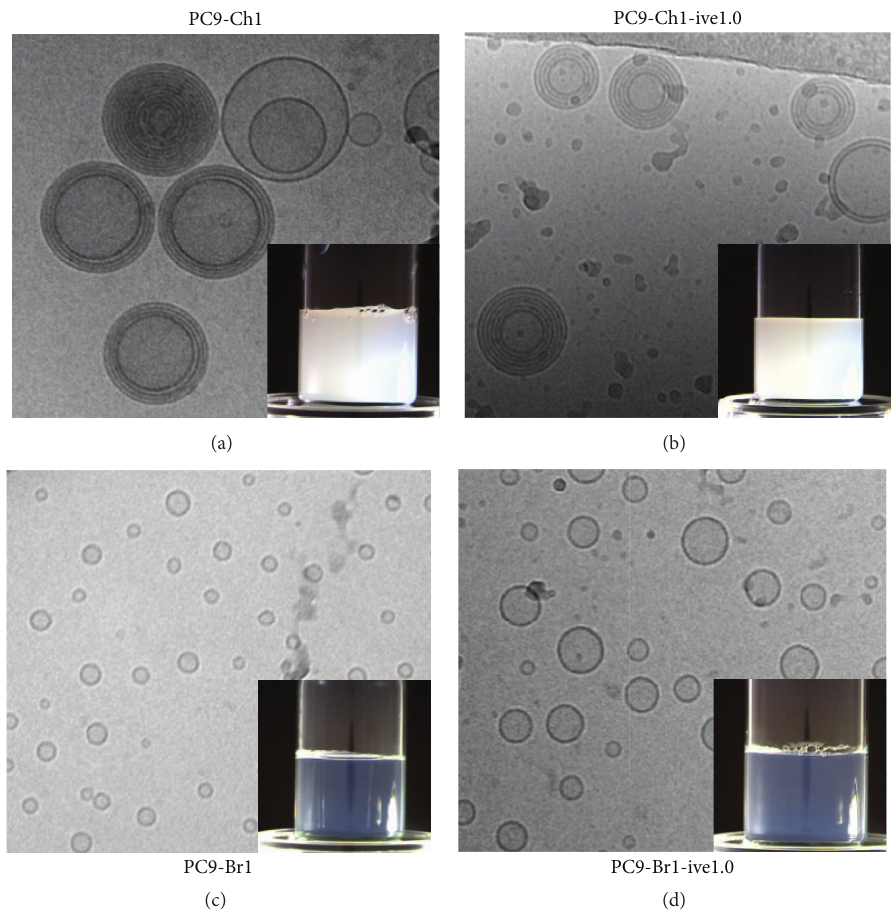
Figure 3: Cryo-TEM analysis of liposomal formulations, namely, #PC9-Ch1 (a), #PC9-Ch1-ive1.0 (b), #PC9-Br1 (c), and #PC9-Br1-ive1.0 (d). Bar corresponds to 700 nm for (a) and (b) and 100nm for (c) and (d). For identification and chemical composition of liposomal formulation, see Table 1. In the insets the macroscopic appearance of the formulation is also